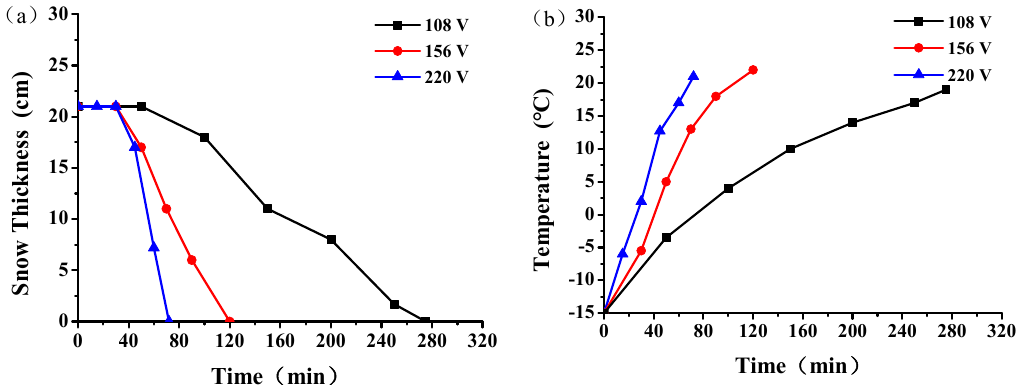
Figure 9. Snowmelt effect of graphene composite conductive concrete under different voltages. ( a ) snow thickness, ( b ) plate temperature rise.